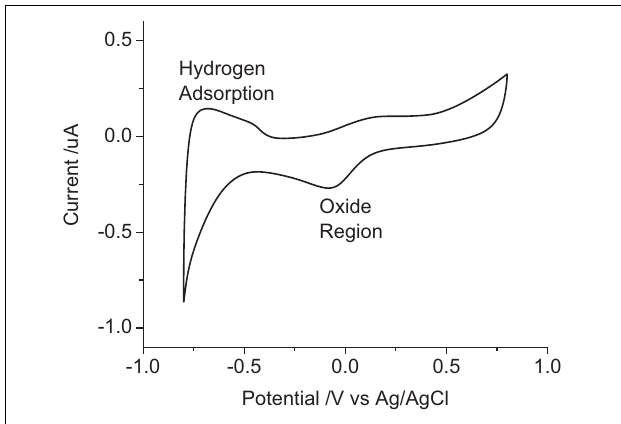
FIGURE 1 | Second cycle of a cyclic voltammogram in degassed 0.1 M NaCl of a mechanically polished 0.6 mm diameter platinum electrode at 100 mV s − 1